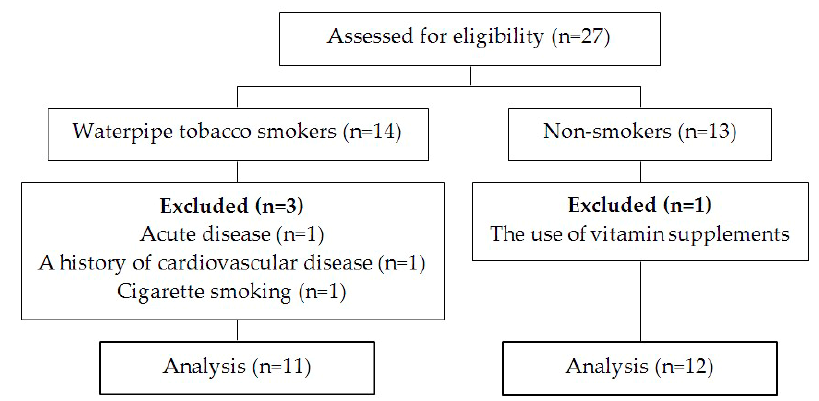
Figure 1. Flow chart of the study from assessment of eligibility to data analysis.